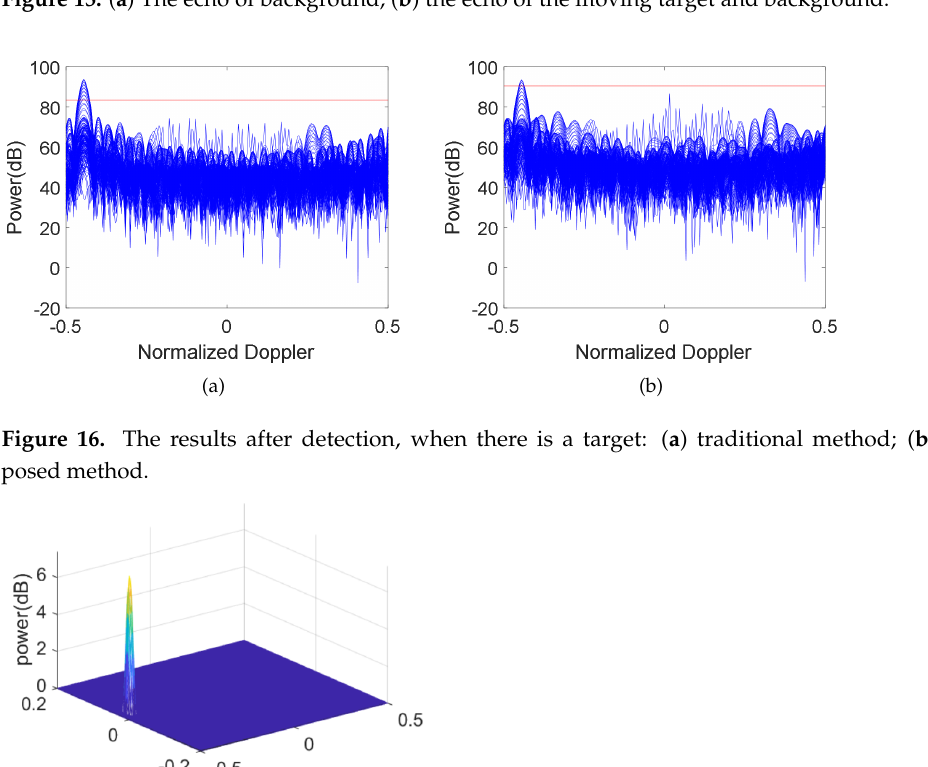
Figure 15. ( a ) The echo of background; ( b ) the echo of the moving target and background.